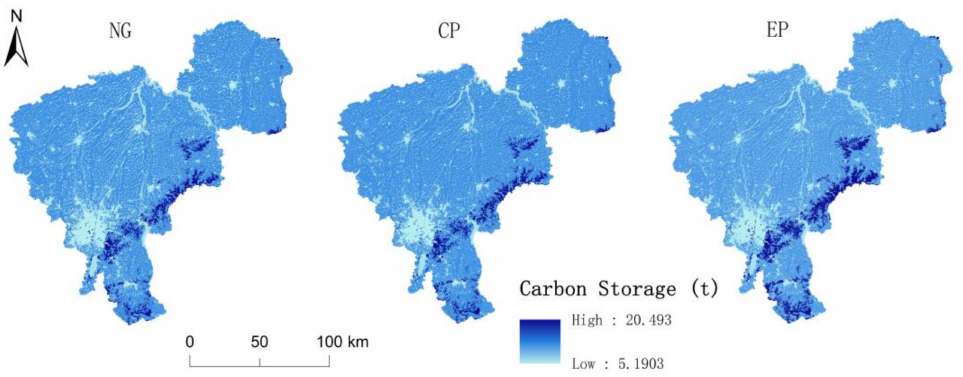
Figure 6. Potential spatial distribution of carbon storage under three scenarios in 2030.